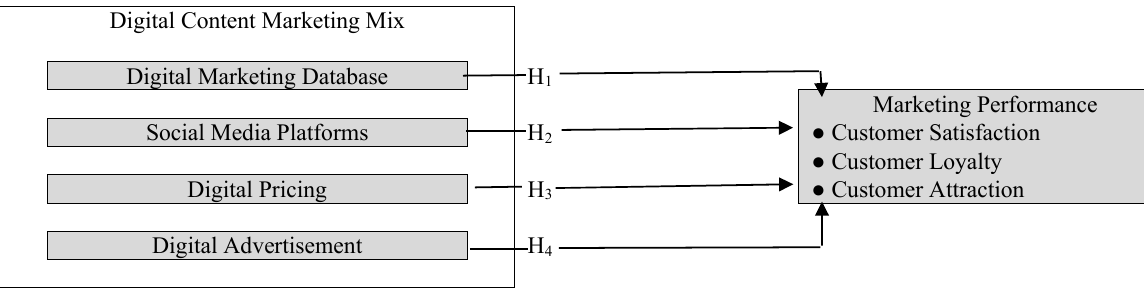
Fig. 1. The research